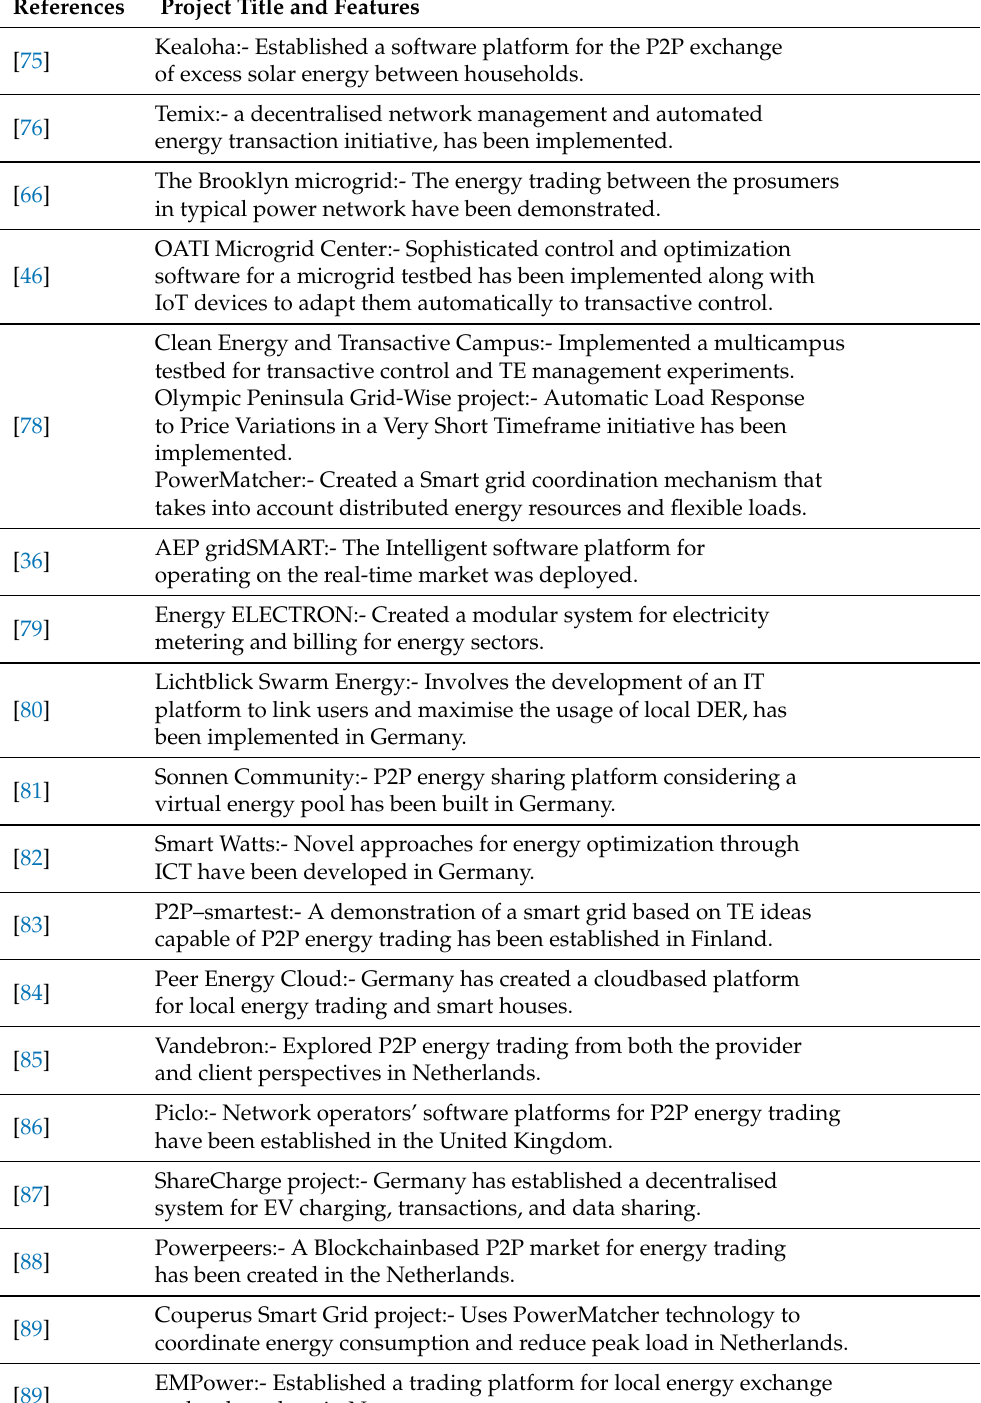
Table 1. Various completed and undergoing transactive energy-based